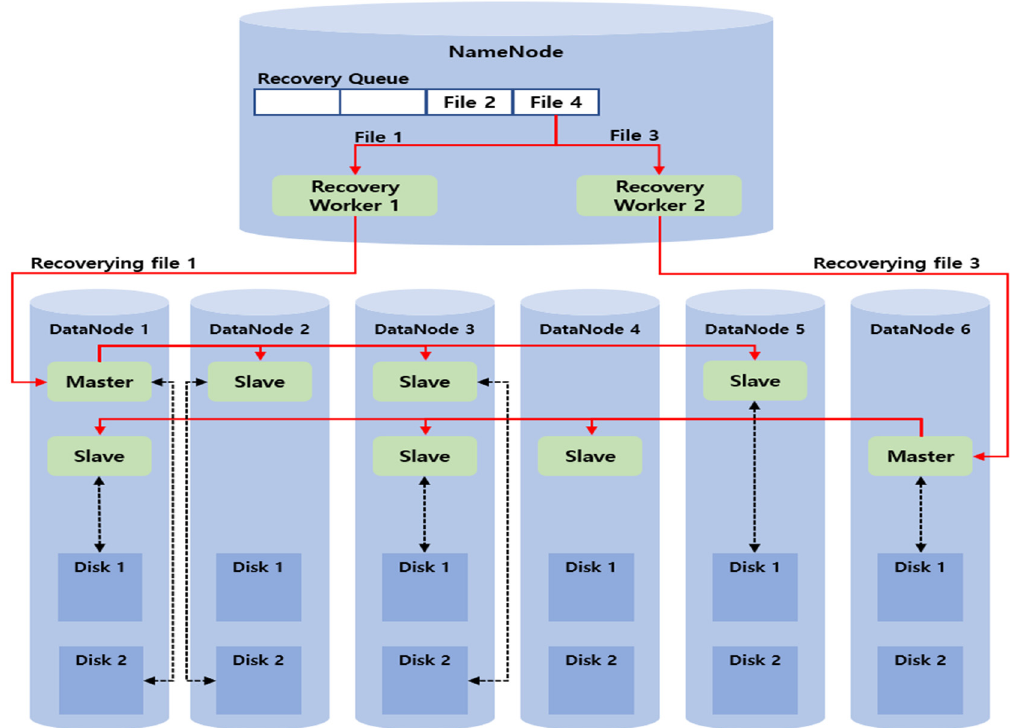
Figure 14. Example of disk contention avoidance due to parallel recovery.